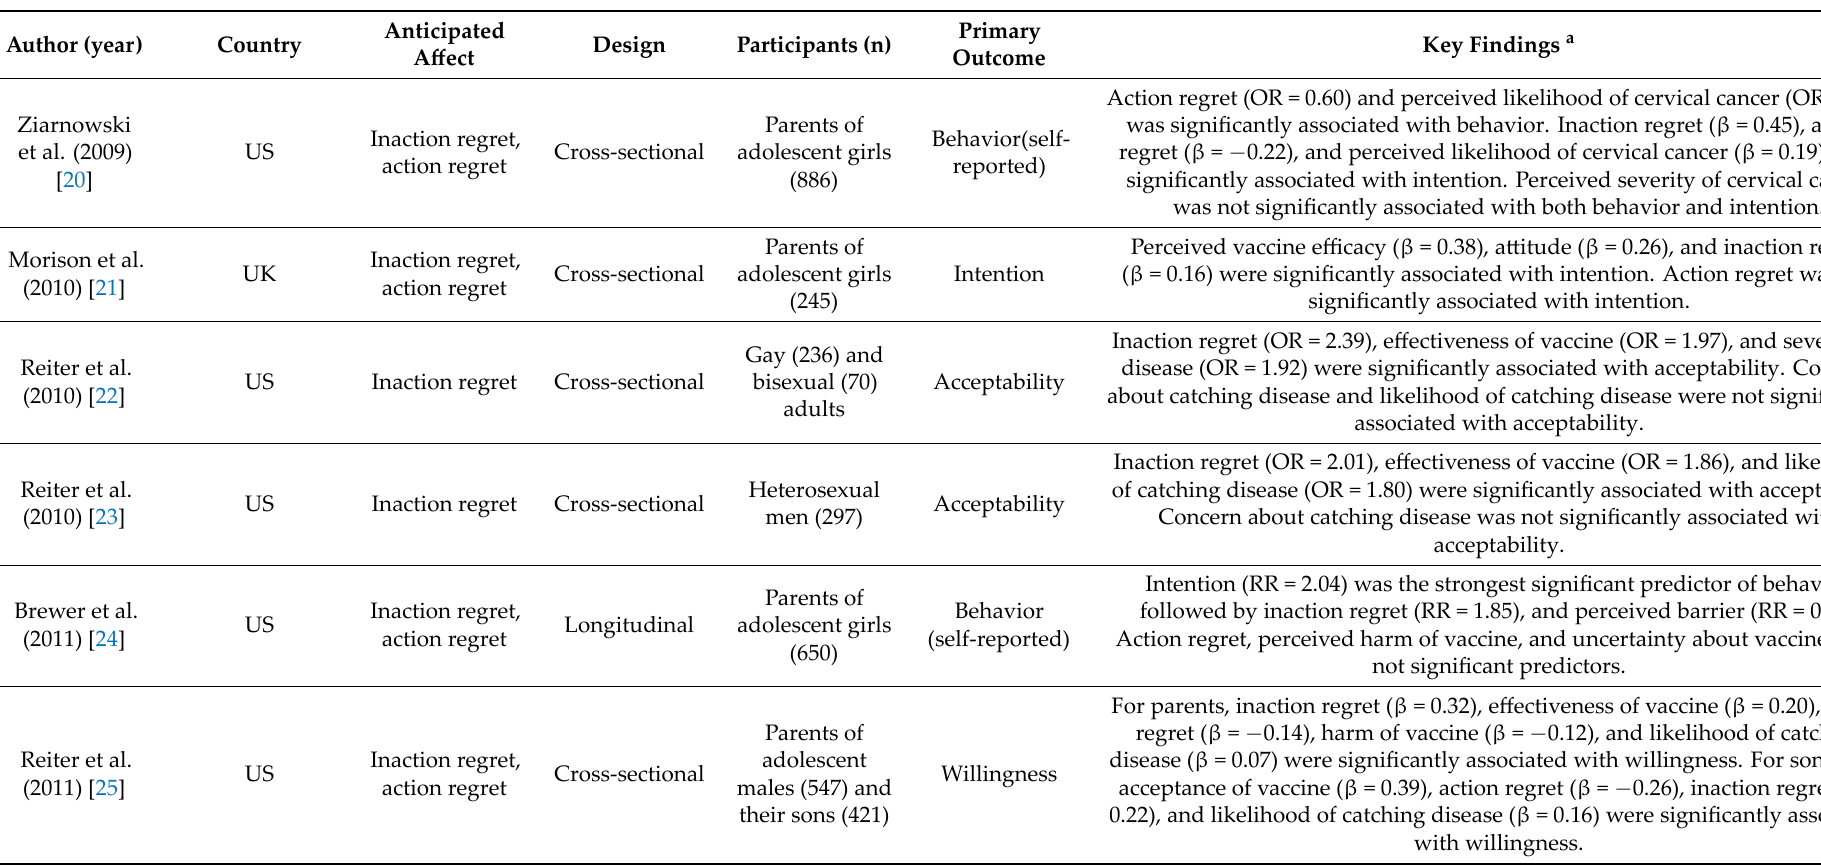
Table 1. Summary of included studies in this